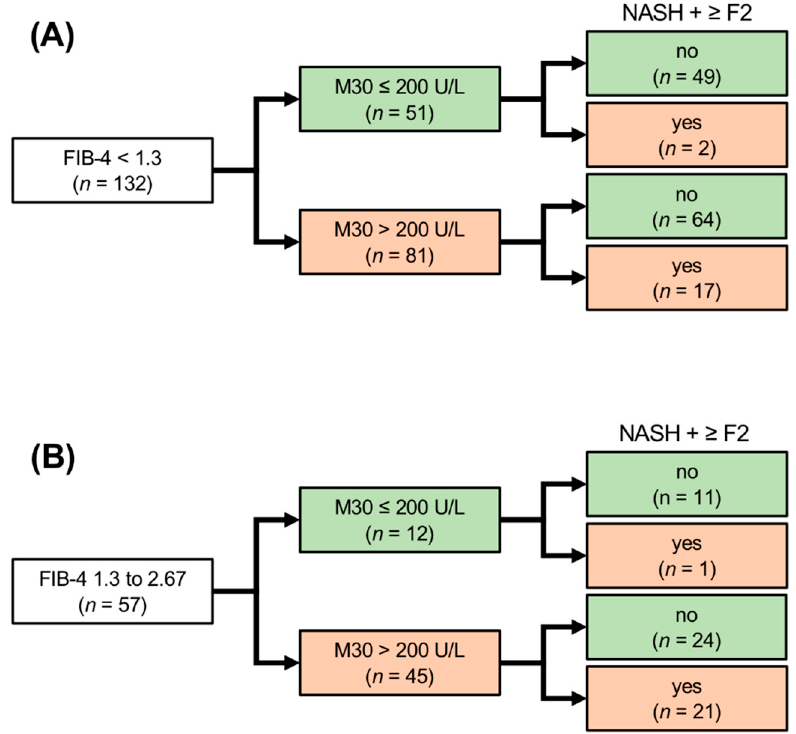
Figure 4. Detection of NASH and significant fibrosis ( ≥ F2) in NAFLD patients with low (<1.3) or intermediate (1.3–2.67) FIB-4 by M30. NAFLD patients of the exploration and validation cohort with